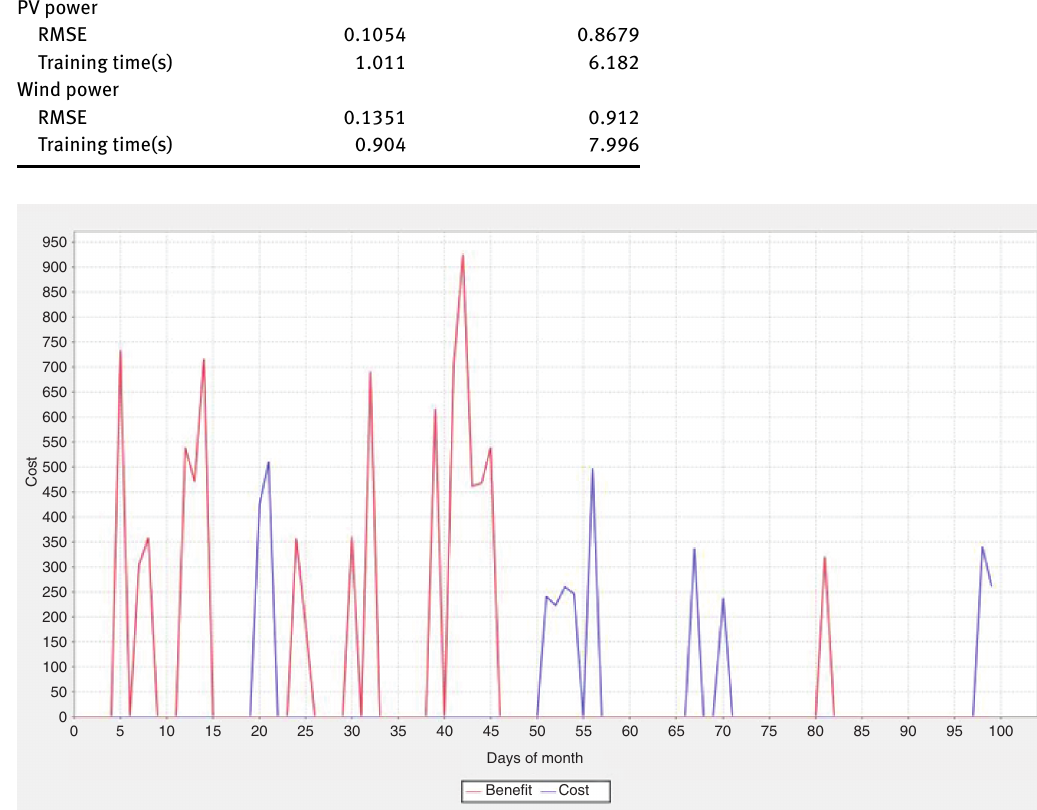
Figure 15: Comparison between Benefits and